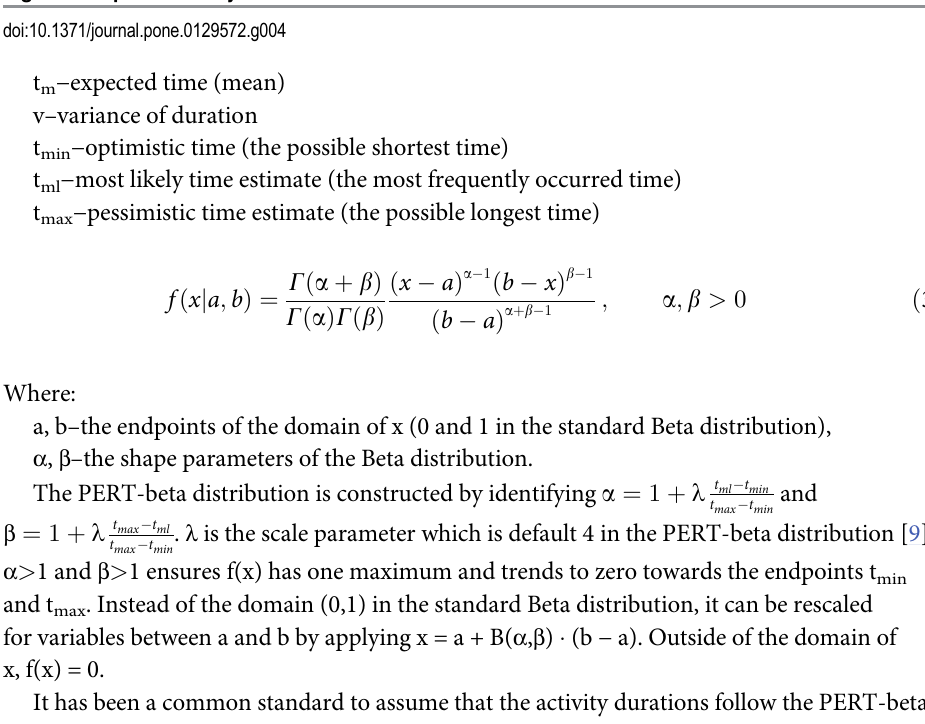
Fig 4. Example of density function of the PERT-beta